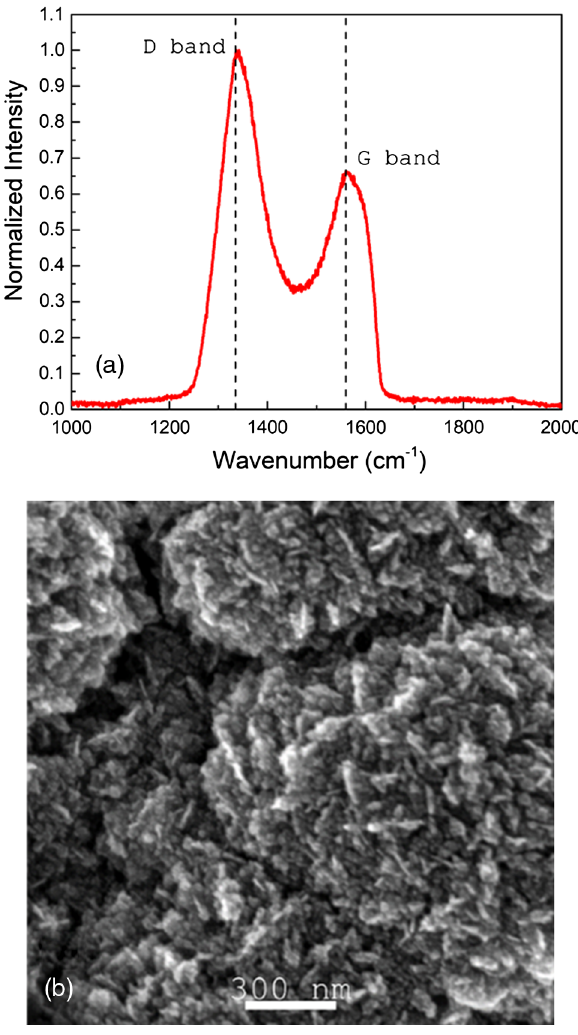
FIG. 1. Raman spectrum and SEM micrograph of as-grown